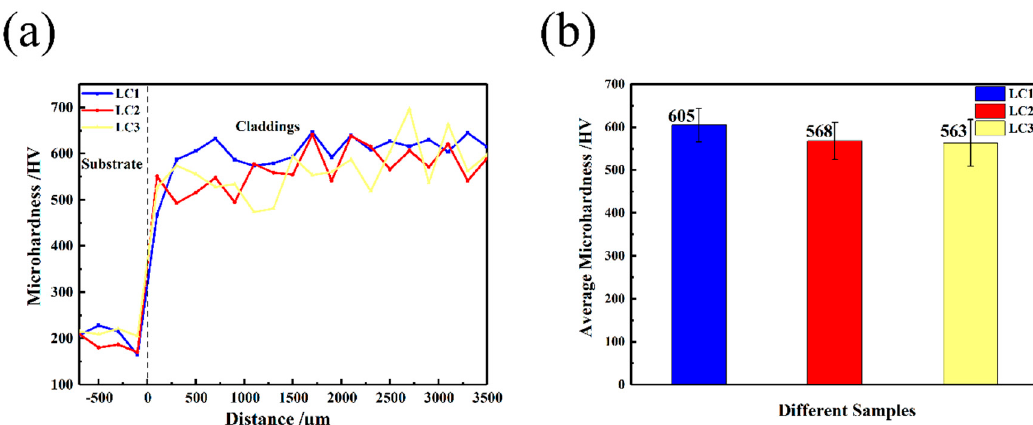
Figure 11. Vickers microhardness of the substrate and cladding coatings: ( a ) Microhardness distribution of cross section; ( b ) average microhardness.